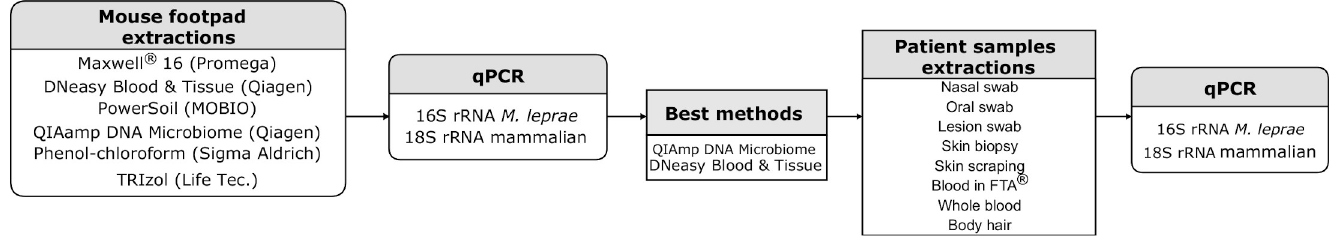
Fig 1. Overall workflow of the